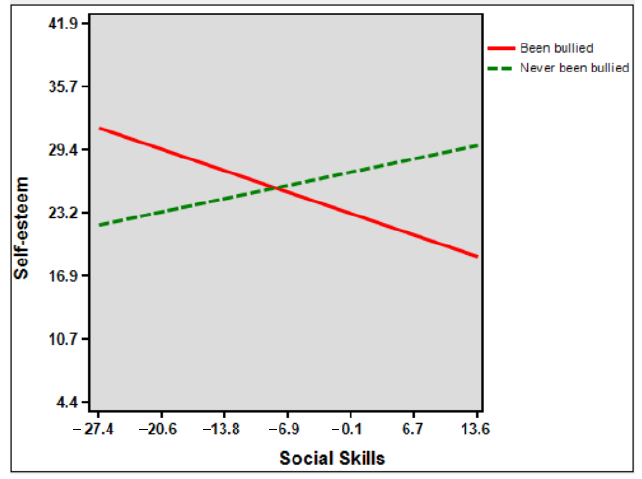
Figure 2. Visual representation of the moderated effect of victim conditions (X) on self-esteem scores (Y) by social skills (W).